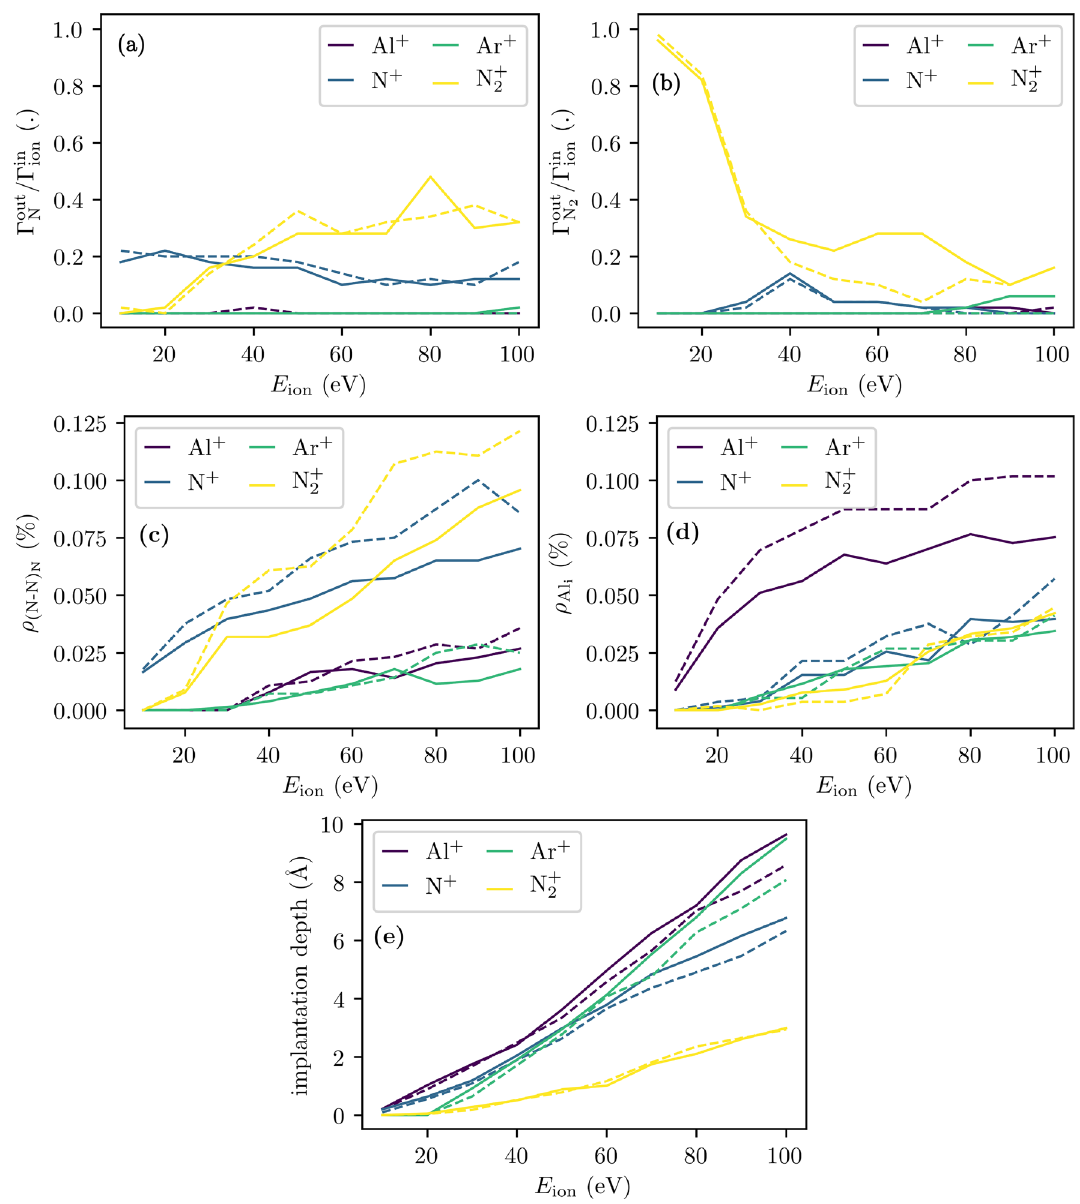
Figure 4. ( a ) Nitrogen flux Ŵ out N and ( b ) molecular nitrogen flux Ŵ out N per incident ion flux Ŵ in ion , ( c ) nitrogen 2 split interstitial population ρ ( N N ) N , ( d ) aluminum interstitial population ρ Al i , and ( e ) implantation depth are − presented as a function of the ion energy E ion and ion species (i.e., Al + , N + , Ar + , N + 2 ). Solid and dashed lines indicate surface initially equilibrated at 300 K and relaxed at 0 K, Fig. 4b. An incident nitrogen ion eventually hits a surface nitrogen atom and forms a nitrogen split interstitial (N–N)